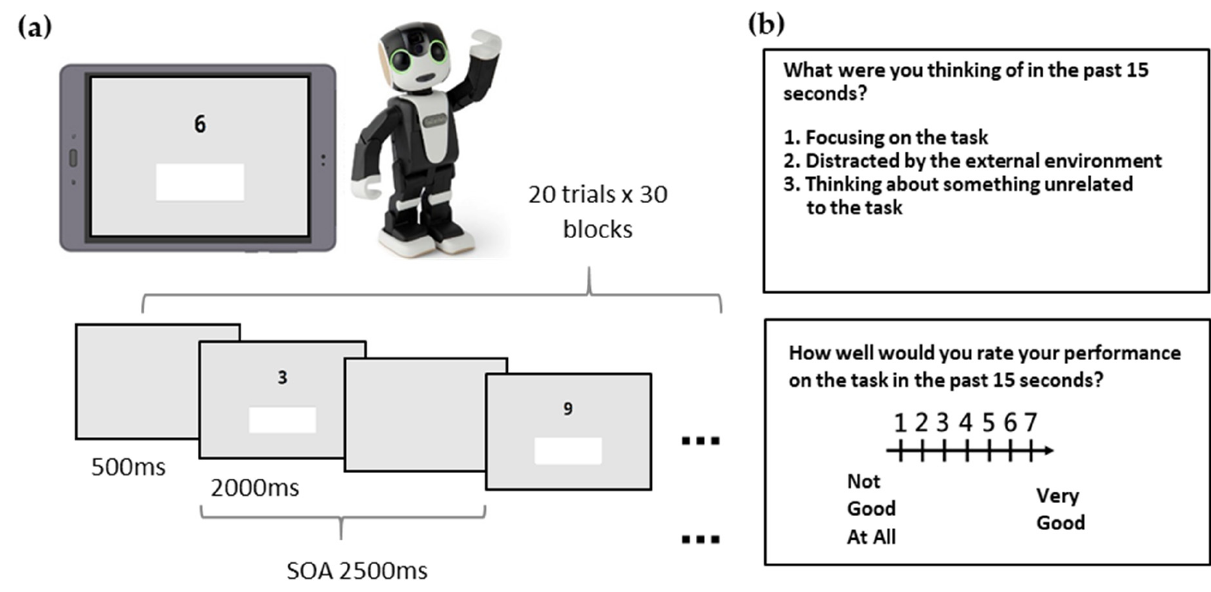
Figure 1. The paradigm of the modified SART. The example image in ( a ) shows the task presented on a tablet beside a RoBoHon robot. The participants were instructed to press the white response button as soon as possible each time a Go-stimulus was presented, if what was presented was a NO-GO target, the participants were required to withhold the button pressing response. ( b ) Illustrates the two probe questions that appeared at the end of each error block whenever any response error had been detected.